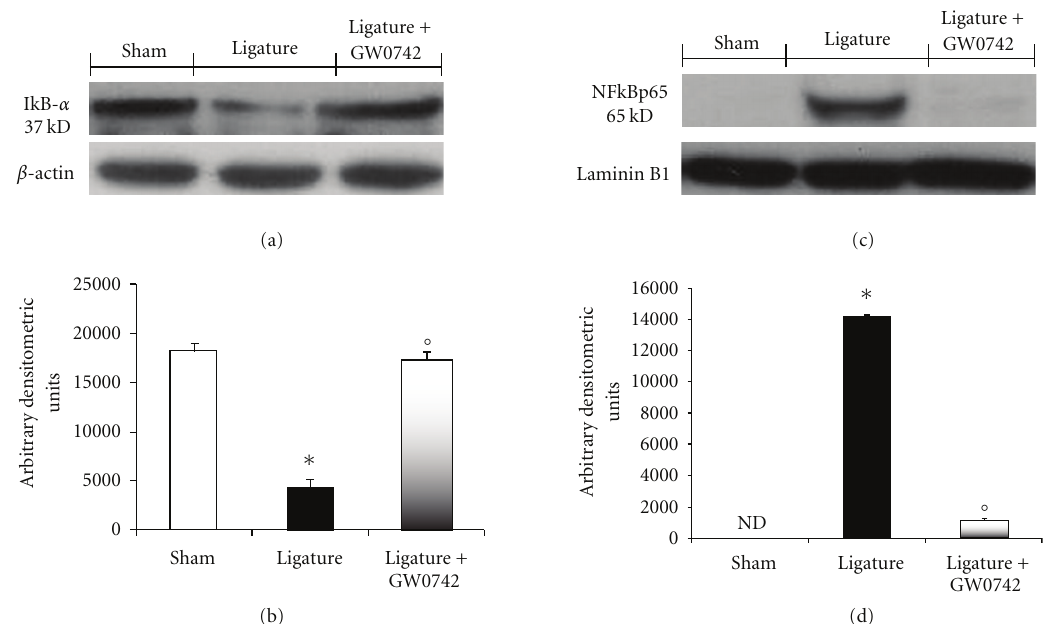
Figure 2: E ff ects of GW0742 treatment on NF- κ B activation in periodontitis. A basal level of I κ B- α was detected in the gingivomucosal tissue sections taken from the contralateral side (a, b). I κ B- α levels were substantially reduced (a, b) in the gingivomucosal tissues from ligature-operated rats. GW0742 treatment prevented I κ B- α degradation, (a, b). Periodontitis caused a significant increase in the NF- κ B p65 levels in the gingivomucosal tissues from operated rats (c, d). GW0742 treatment significantly prevented NF- κ B p65 expression (c, d). A representative blot of lysates obtained from 5 animals per group is shown and densitometry analysis of all animals is reported. The results in (b, d) are expressed as mean ± S.E.M. from n = 5 / 6 gingivomucosal tissues for each group. ∗ P < 0 . 01 versus nonligated group. ◦ P < 0 . 01 versus ligated